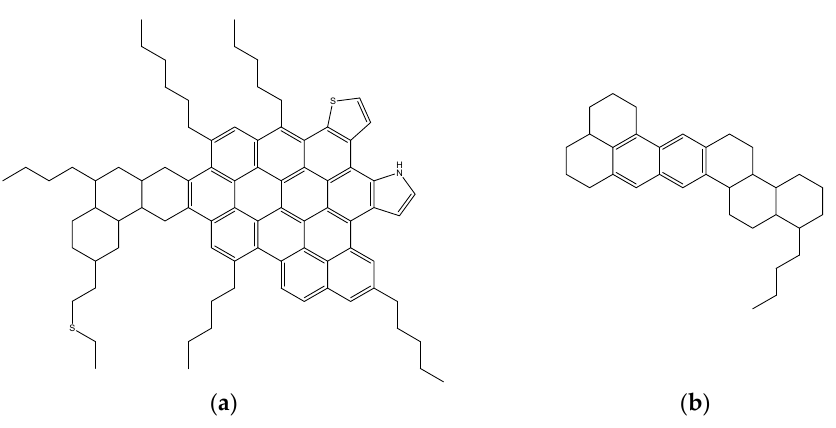
Figure 5. Examples of molecular structures of asphaltene ( a ) and resin ( b ).